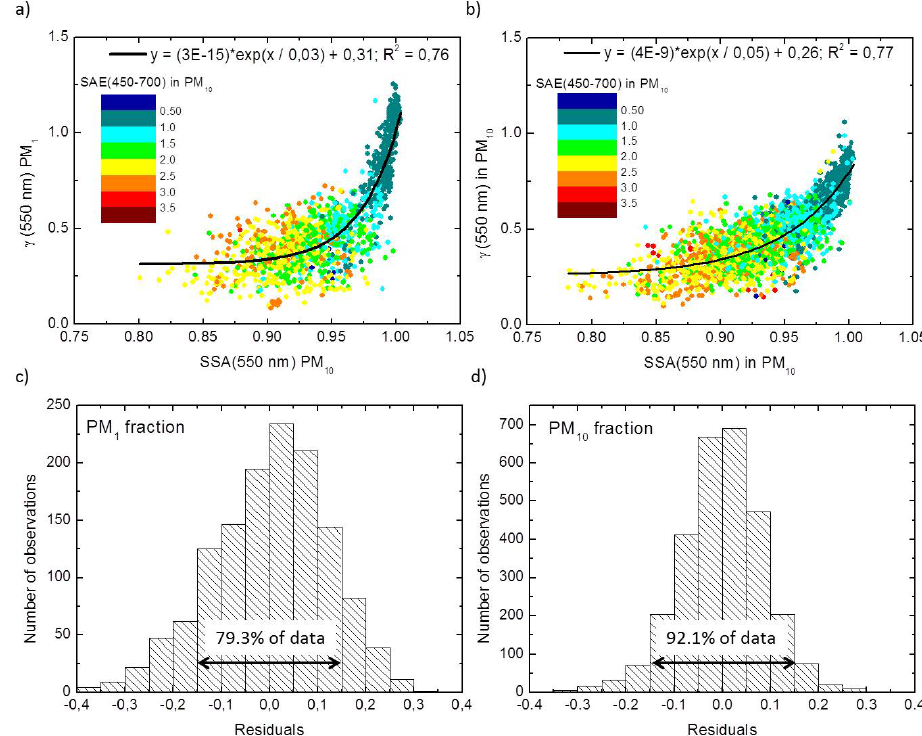
Figure 8. γ parameter in PM 1 (a) and PM 10 (b) vs. the single scattering albedo in PM 10 . The color code corresponds to the scattering Ångström exponent in PM 10 . An exponential fit has been added to the plot (black line). The residuals of these regressions are plotted as frequency distributions for PM 1 (c) and PM 10 (d) size fractions.